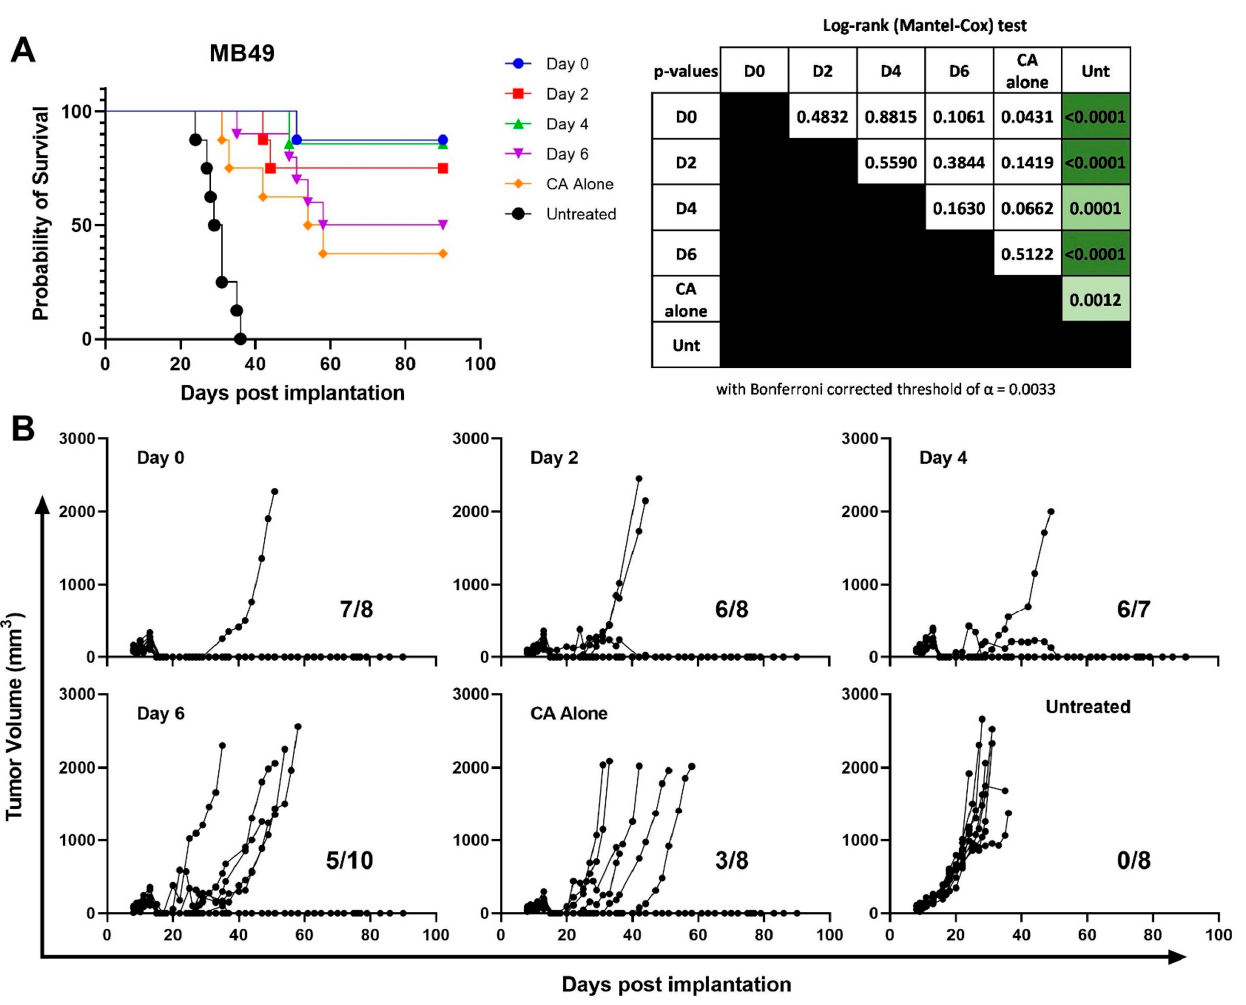
Figure 2. Effect of adjuvant CS/IL-12 timing on recurrence prevention. In the MB49 model, mice were treated with either CA alone or CA + CS/IL-12 delivered either within an hour of CA (Day 0), 2 days, 4 days, or 6 days after CA. Survival ( A ) and tumor volume ( B ) were monitored for 90 days post implantation. Statistical significance was calculated using the Log-rank (Mantel–Cox) test and a table of p -values for each comparison is shown next to the survival curve ( A ). Comparisons with a significant difference below the Bonferroni corrected threshold are highlighted in green. Fractions in ( B ) refer to the number of mice without a primary tumor recurrence at the end of the study.